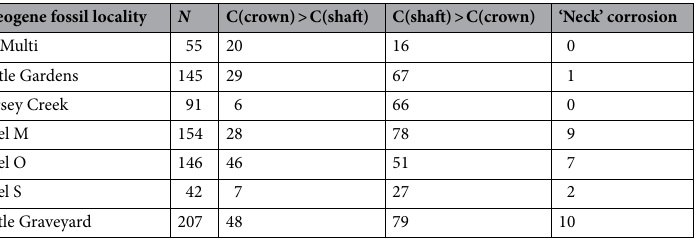
Table 4. Summary of corrosion damage to lizard teeth from seven Paleogene localities in Wyoming, USA. These numbers generally cannot be directly compared with the foregoing, because they pertain only to identified specimens. Thus, if corrosion was present but so extensive that it precluded identification, then it would not be counted.